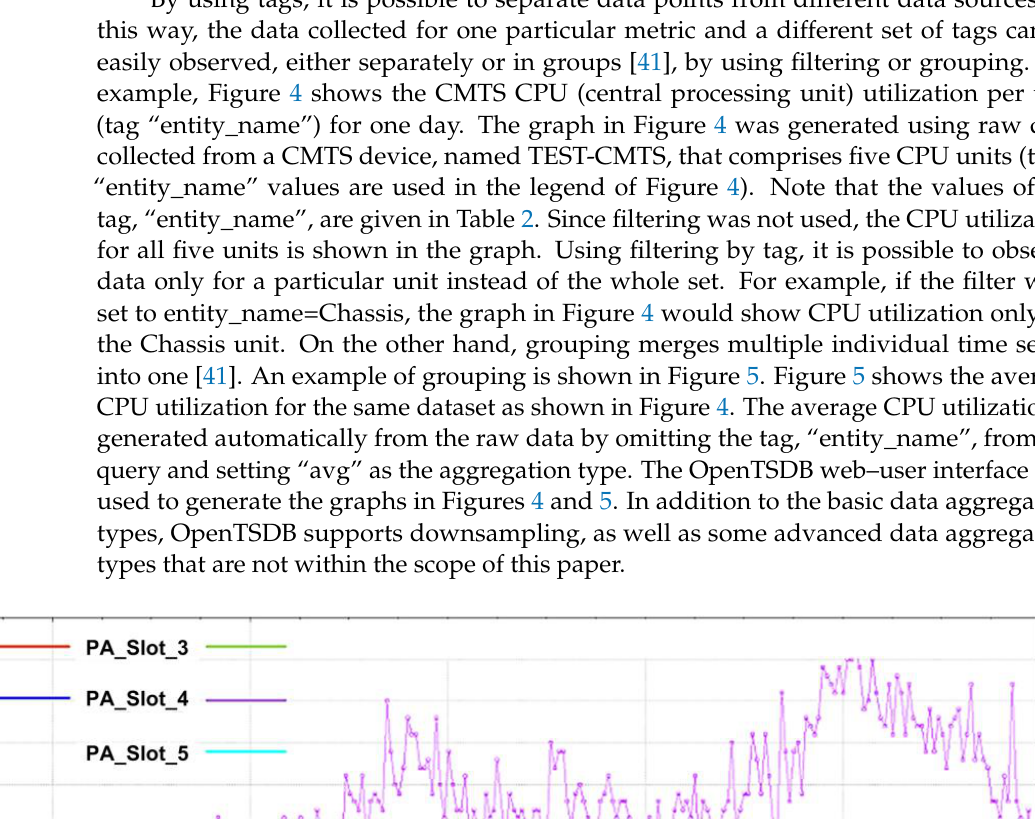
Figure 5. Average CMTS CPU utilization.